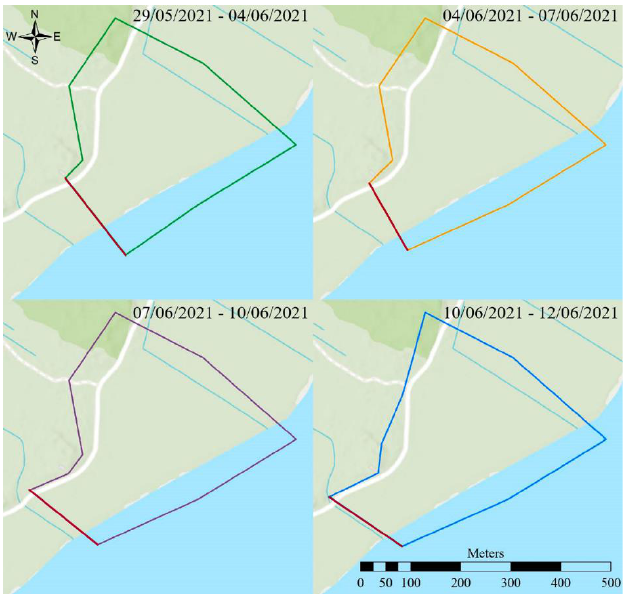
Figure 1. The semi-virtual enclosure on the island Fanø in the Danish Wadden Sea during 29 May to 12 June 2021. Only the southwestern fence line was completely virtual (red line); for the remaining borders, there was still a physical fence within the virtual border. The coordinates of the lower right corner of each map frame are 8 ◦ 27 (cid:48) 59 (cid:48)(cid:48) E, 55 ◦ 24 (cid:48) 4 (cid:48)(cid:48)